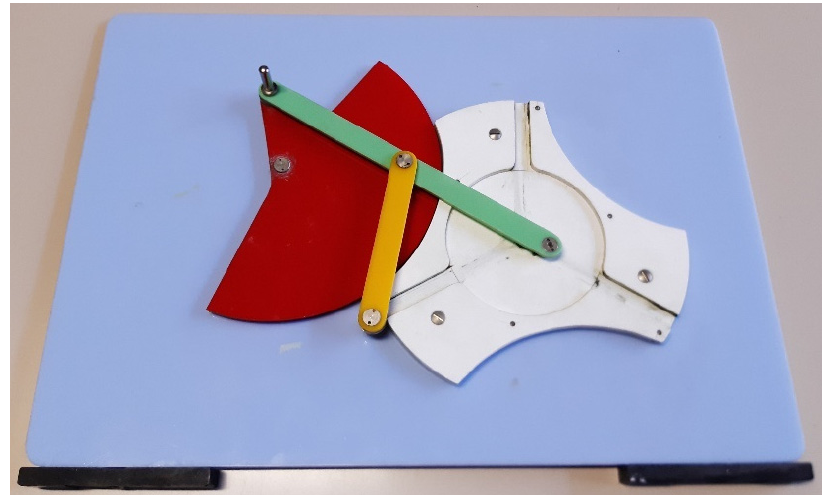
Figure 4. Intermittent mechanism model made of colored bakelite at the University of Bologna. Iron models, more expensive than the previous ones, are often used to show the complexity of a real machine rather than a specific mechanism. They are models with cutaways to reveal the internal components. More realistic than previous types, these models are intended to show the real components that are the result of different types of analysis, such as the cooling fins of an engine, which have implications in the thermal analysis but not in mechanical ones. Figure 5 shows a model of the iconic motorcycle, Lambretta, a 2-stroke single-cylinder engine, piston, head and crankcase made of aluminum alloy with a cast iron cylinder. The engine is part of the collection at the Museum of Engines and Mechanisms of the University of Palermo [37].